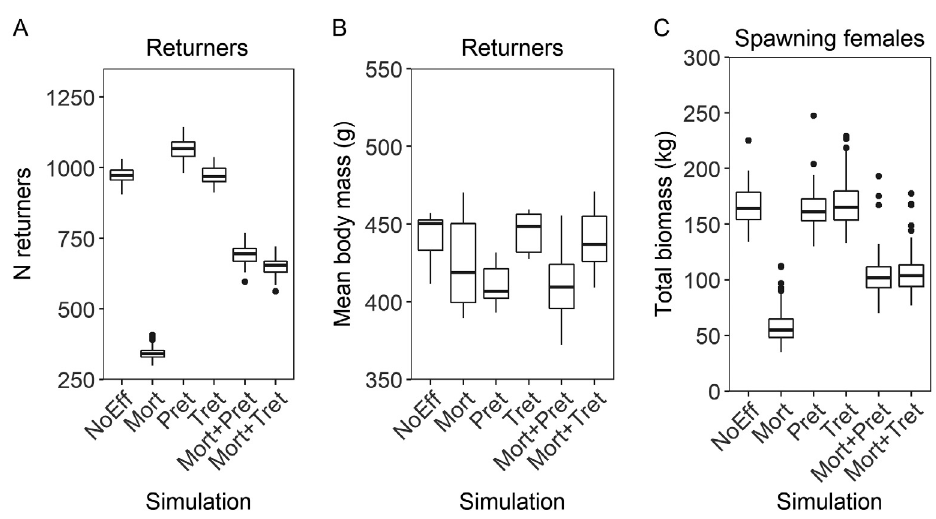
Fig. 7. (A) Number of returners, (B) mean body mass of returners and (C) total biomass of spawning females under conditions of no lice effects (NoEff), lice-induced mortality (Mort), lice-induced persistent premature return (Pret), lice-induced transitory premature return (Tret), lice-induced mortality plus persistent premature return (Mort + Pret), and lice-induced mortality plus transitory premature return (Mort + Tret). Here and in Figs 8 & 9, boxplots are created from annual